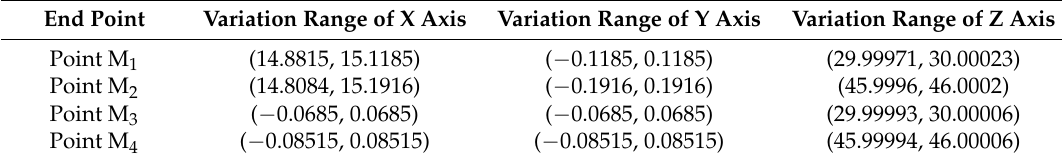
Table 3. Variation ranges of four end points of the gear axis (Unit: mm).